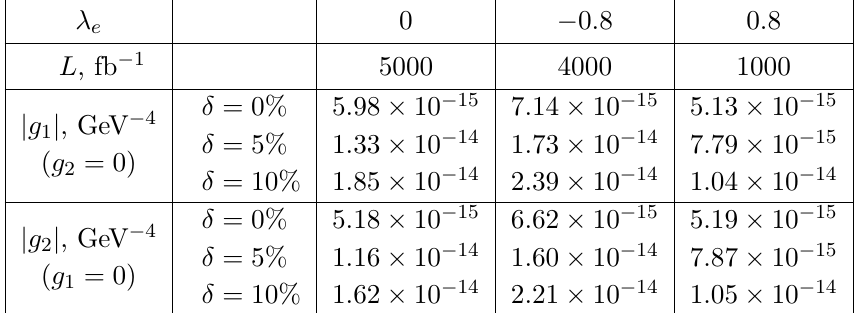
√ s = 3000 GeV and different values of the